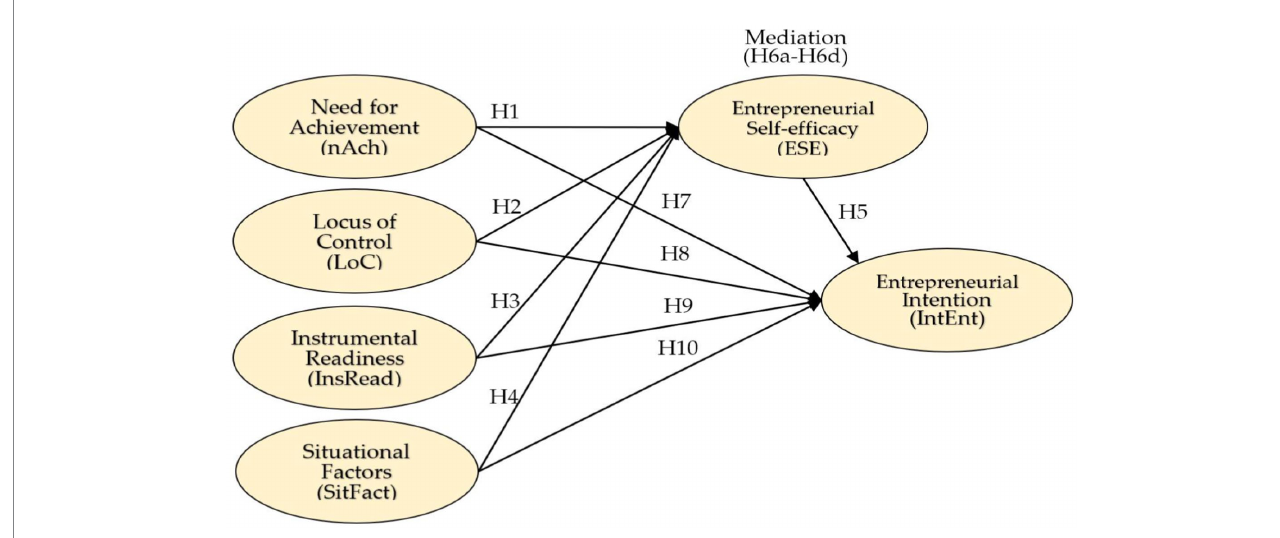
FIGURE 1 Conceptual framework and hypothesized relationships.